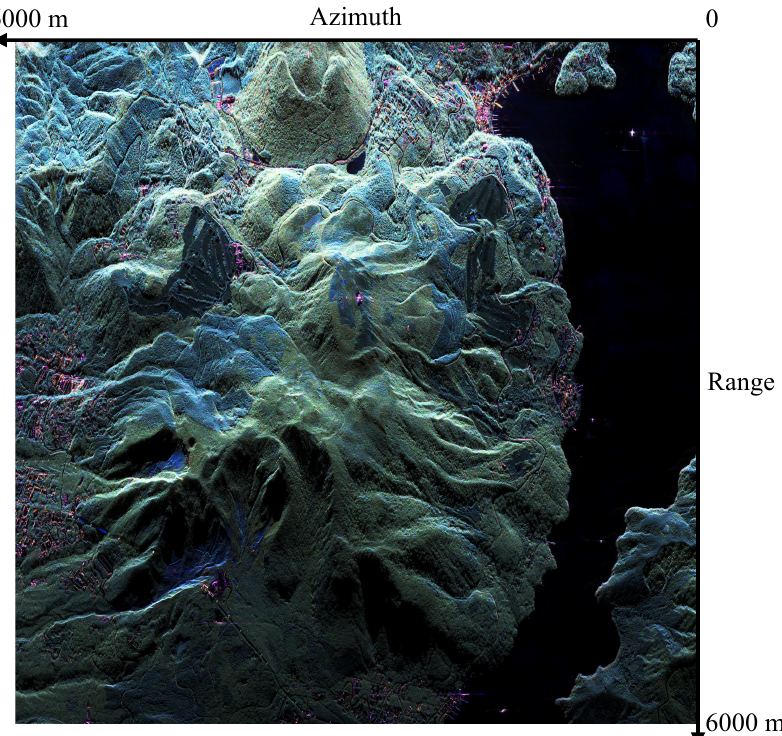
Figure 12. 6SD image after calibration around Mount Hakone on 3 December 2015 (Center: N35.218,